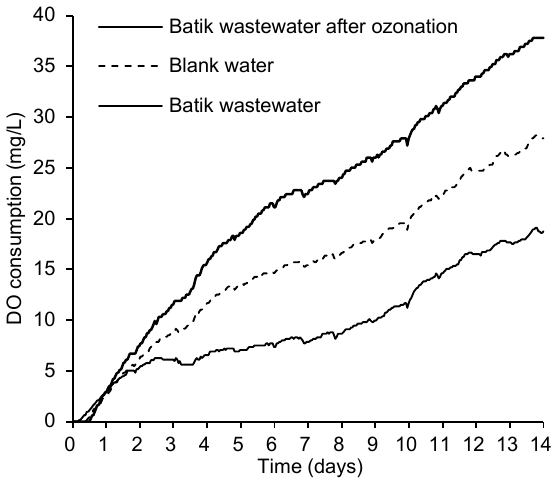
Figure 5. DO consumption by activated-sludge microorganisms at 25 °C in synthetic batik wastewater containing 48 mg/L RB5 and 48 mg/L RO16 before and after 15 min ozonation.